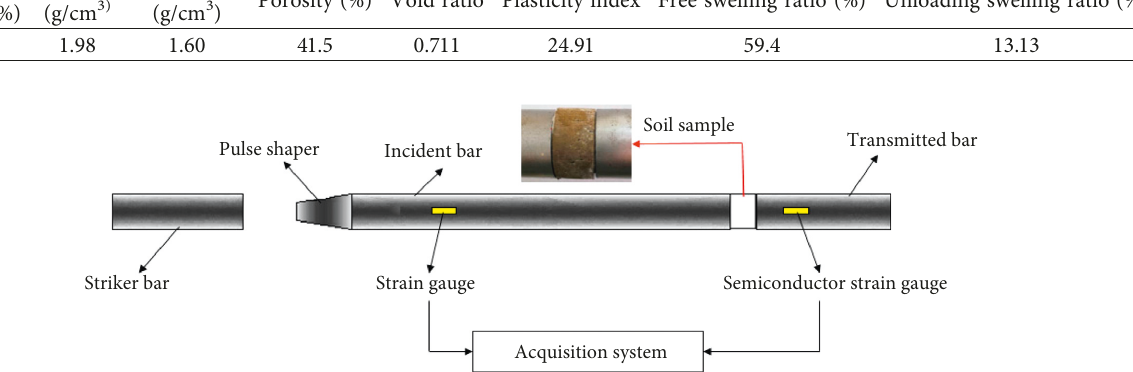
Figure 1: Schematic diagram of the SHPB test device.